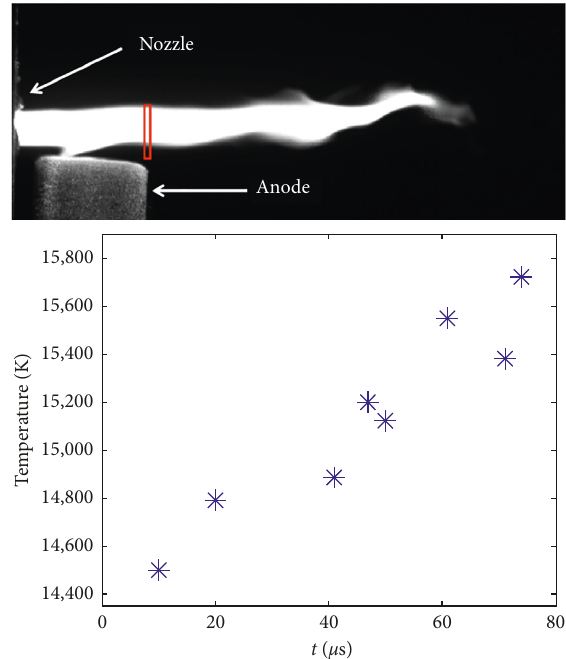
Figure 8: Temporal evolution of temperature during one period of restrike mode (measured in position 3 as shown by the red rect- angle in high-speed camera image above the graph).